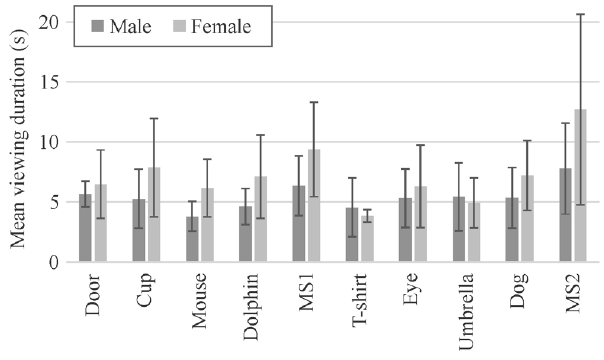
Fig. 4 Mean viewing duration and SD for the free-viewing